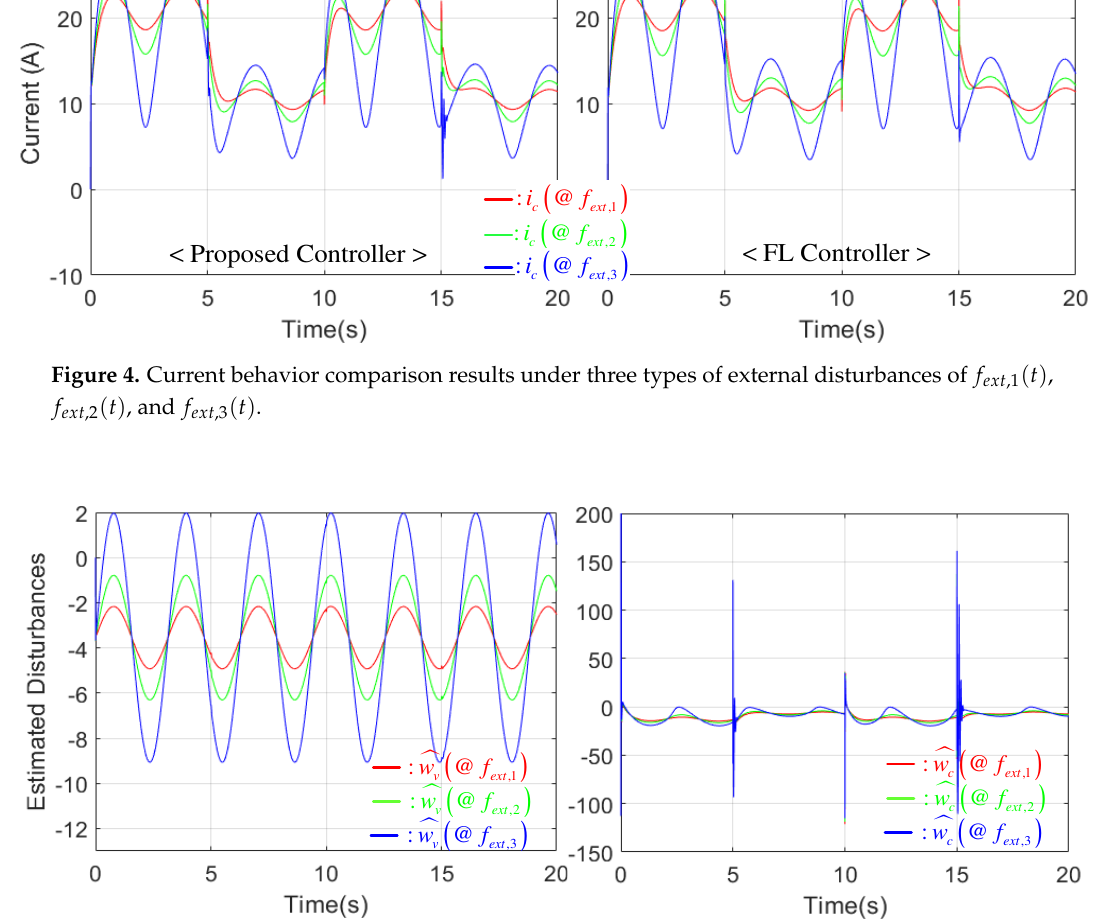
Figure 5. DOB behaviors.